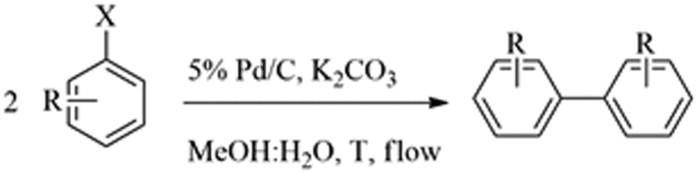
Pd-catalysed Ullmann coupling at room temperature.